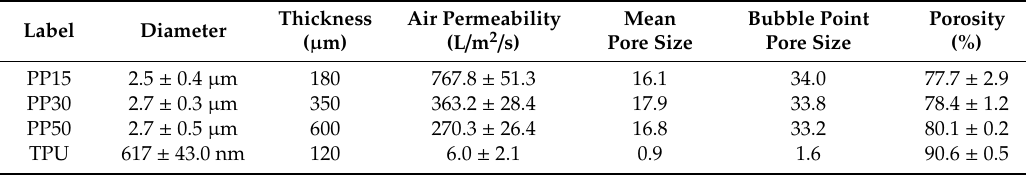
Figure 2. ( a ) Schematic of the highly porous TPU / PP nonwoven triboelectric layers; ( b , c ) cross-sectional FE-SEM images of the integrated TPU / PP nonwoven layers; ( d , e ) surface morphologies of the porous nonwoven PP and TPU nanofiber mat; ( f , g ) 3D surface scanning image and surface roughness graph of the nonwoven PP and TPU nanofiber mat; and ( h , i ) pore size distribution and maximum / average pore diameter of both nonwoven fabrics. Table 1. Basic properties of the nonwoven PP and TPU nanofiber